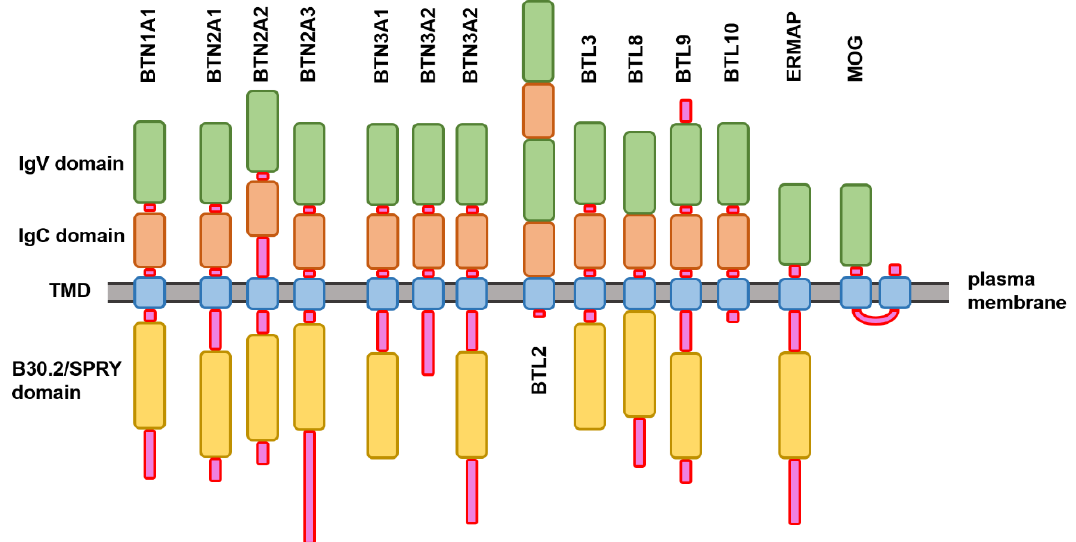
Figure 1. Schematic representation of the modular domain structure of the members of human butyrophilin family. Positions of various functional domains of these proteins relative to the plasma membrane are shown.